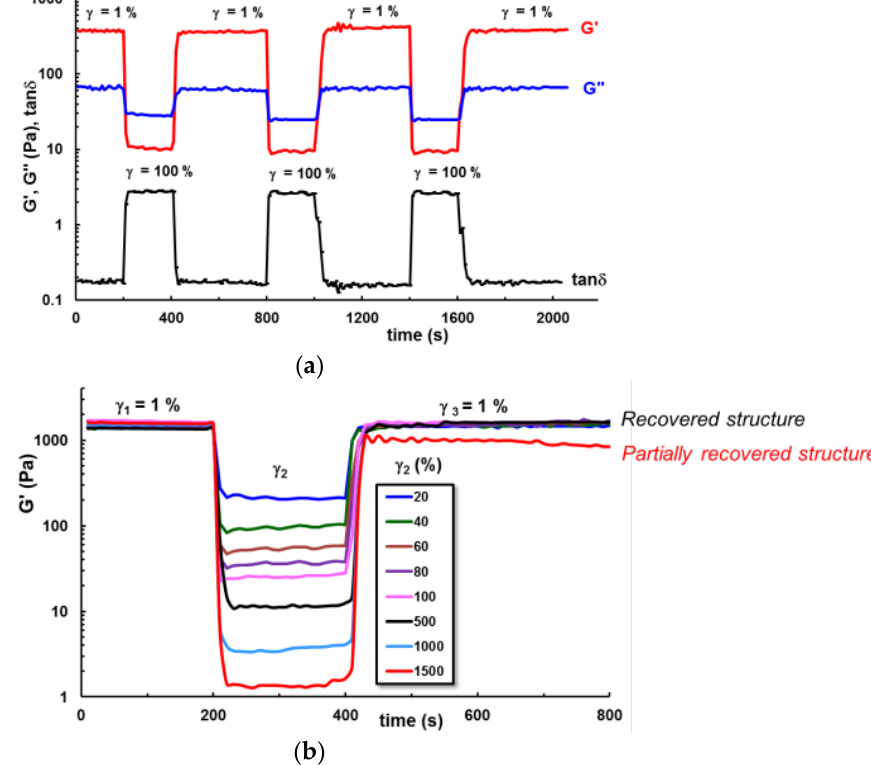
Figure 7. ( a ) Illustration of a thixotropy test demonstrating the ability of hydrogels to rapidly recover their structure after successive cycles of deformations. The deformation of 1% belongs to the linear viscoelastic regime and the high level of deformation ( γ = 100%) is in a nonlinear viscoelastic regime. ( b ) Third test interval thixotropy demonstrates the ability of structural regeneration after successive cycles of low (simulating the rest state) and high deformations, γ 2 (the sample was submitted to increasing levels of deformation during each cycle). Adapted from [125].